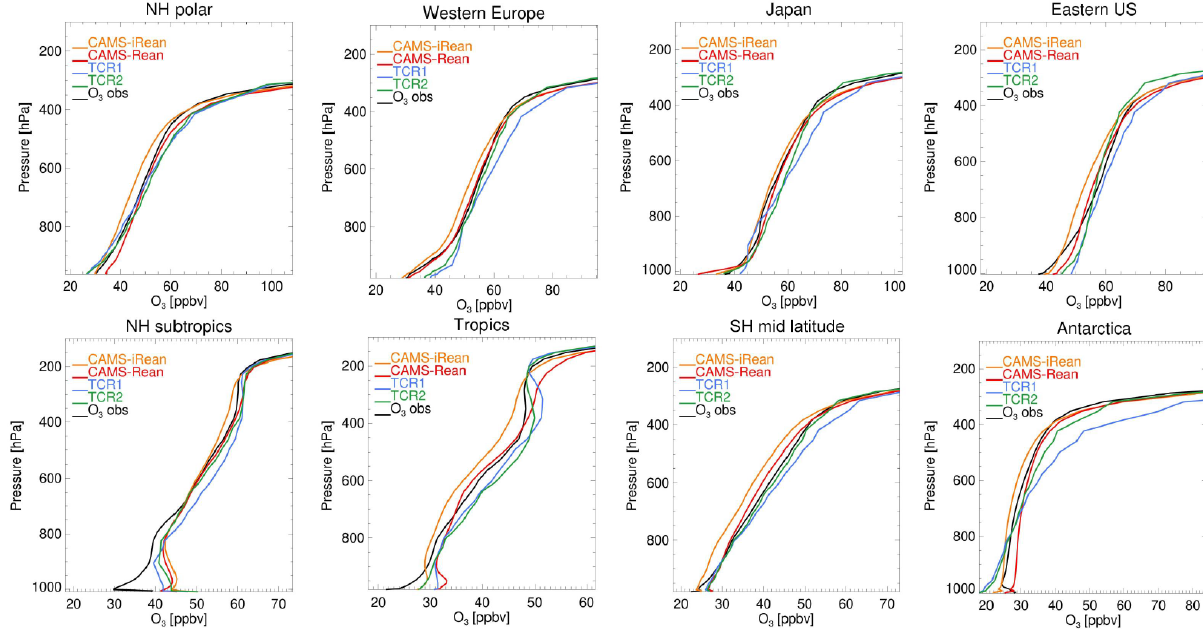
Figure 2. Evaluation of regional mean multiannual mean O 3 profiles against ozone-sondes, averaged over the 2005–2016 time period.